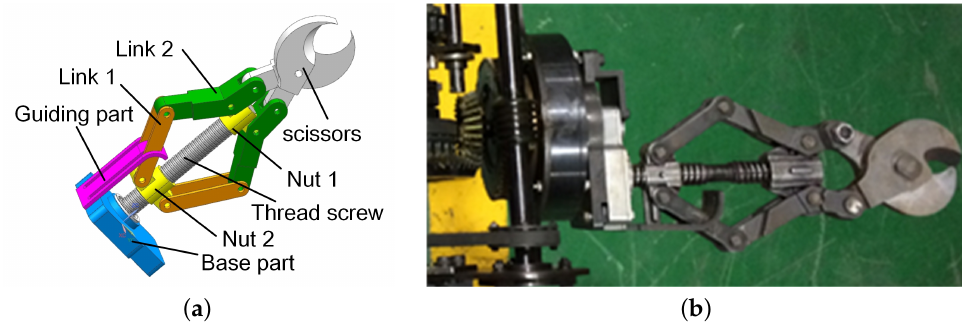
Figure 22. Structure of the scissors [9]. ( a ) The 3D model of the scissors. ( b ) The prototype of the scissors.